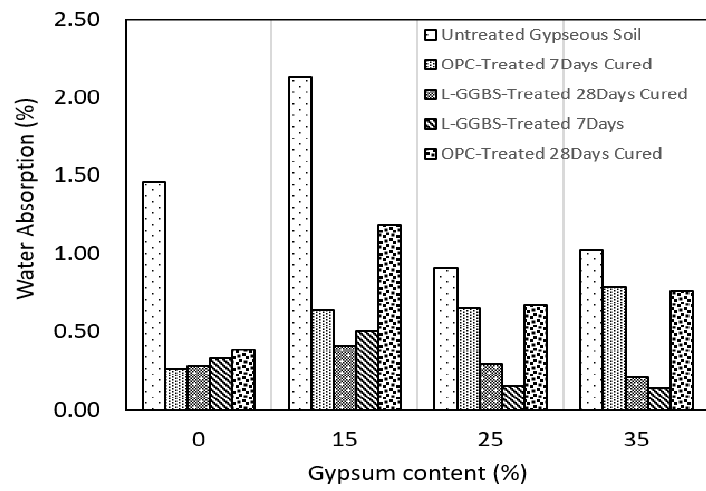
Figure 7. Water absorption of treated and untreated gypseous